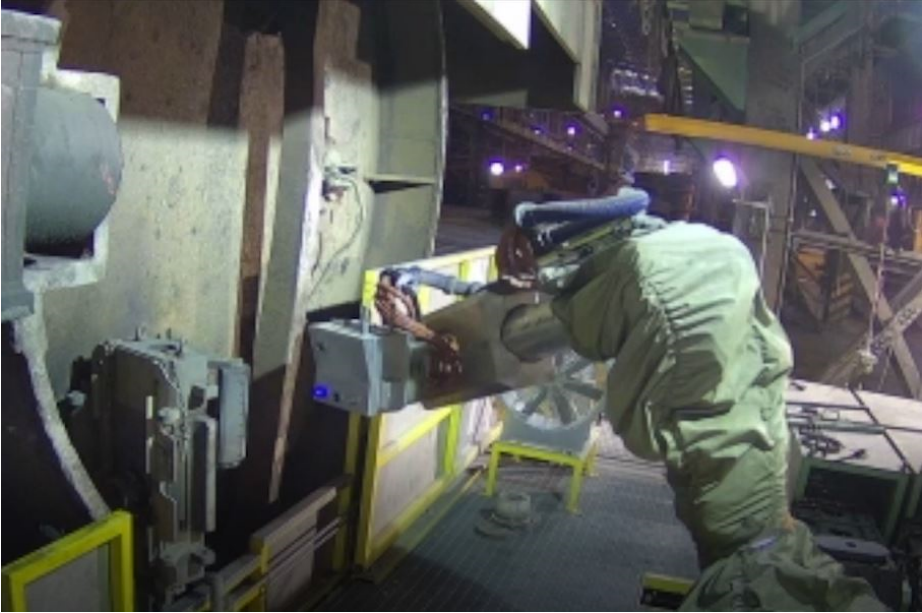
Figure 4. The robot inspects the opened sliding gate by means of the vision tool.